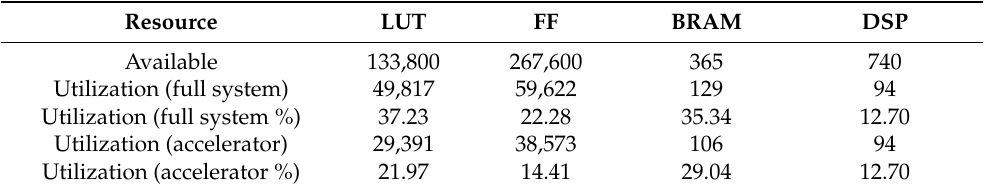
Table 1. Resource utilization of the hardware